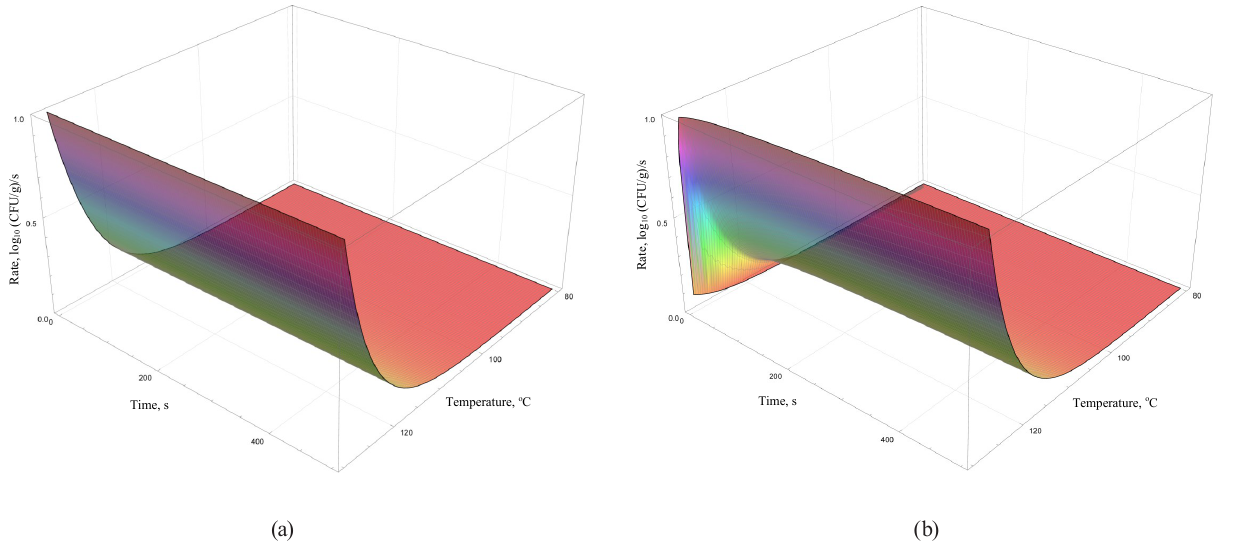
Figure 10 Model of the rate dynamics for microbial death kinetics of A. acidoterrestris during heat treatment.